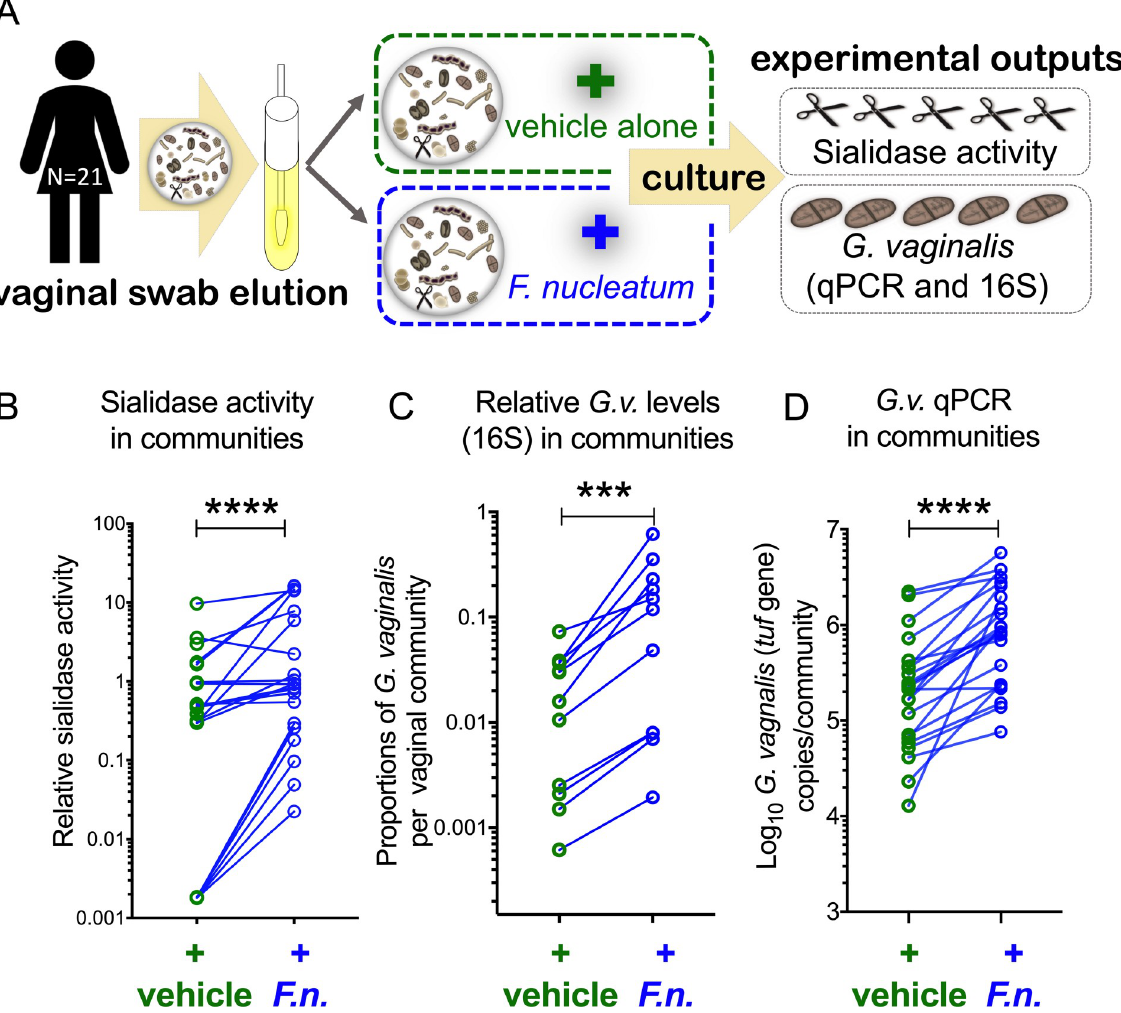
Fig 7. F . n . supports Gardnerella growth and stimulates sialidase activity within human vaginal communities. (A–D) Human vaginal communities from 21 individual women were used. (A) Microbial communities were eluted from vaginal swabs under anaerobic conditions in nutrient-rich media. Communities with potential sialidase producers (sialidases are represented as scissors) were cultivated anaerobically in supplemented Columbia media in the presence or absence of added F . n . (B) Sialidase activity was measured following anaerobic culture. Negative values were set to 0.0018 (lowest positive value) to depict them on the log scale. Graphs show data combined from 2 independent experiments. (C) Relative abundance of G . v . in cultured human vaginal communities. Sequencing of the gene encoding the V4 region of 16S rRNA was used to estimate proportions of G . v . in the microbial communities. (D) Quantitation of G . v . in cultured human vaginal communities by tuf qPCR. In each case, statistical comparison between the 2 groups was performed using Wilcoxon matched-pairs signed rank test. The underlying numerical data for this figure can be found in S1 Data. On all graphs, ��� P < 0.001, ���� P < 0.0001. F . n ., F . nucleatum ; G . v ., G . vaginalis ; qPCR, quantitative PCR; tuf , Translation elongation factor